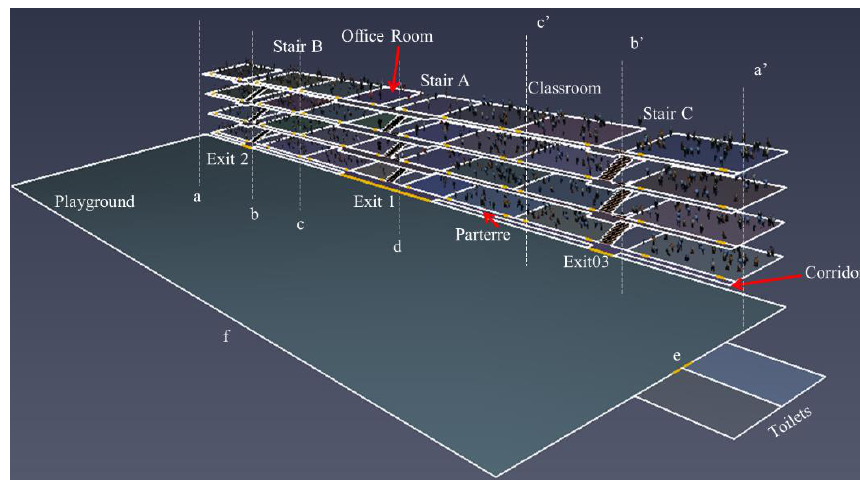
Figure 1. Special model for the ChengGuan Primary School.